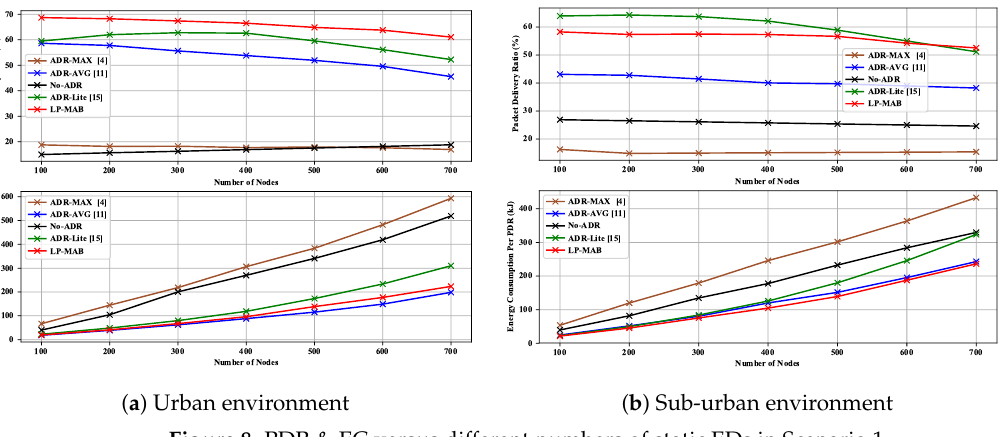
Figure 8. PDR & EC versus different numbers of static EDs in Scenario